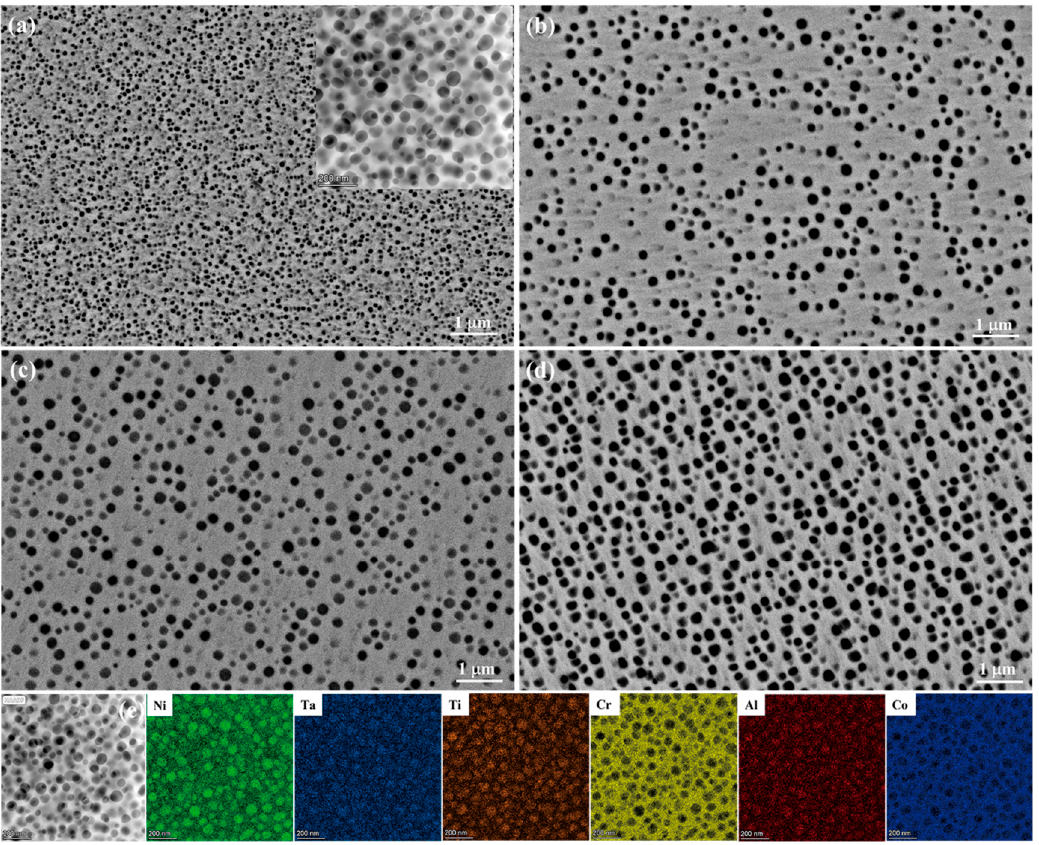
Figure 1. The morphology evolutions of γ′ precipitates for samples ( a ) HT1, ( b ) HT2, ( c ) HT3, and ( d ) HT4, and ( e ) HAADF-TEM image and the EDS map of the γ′ phases in the HT1 sample.